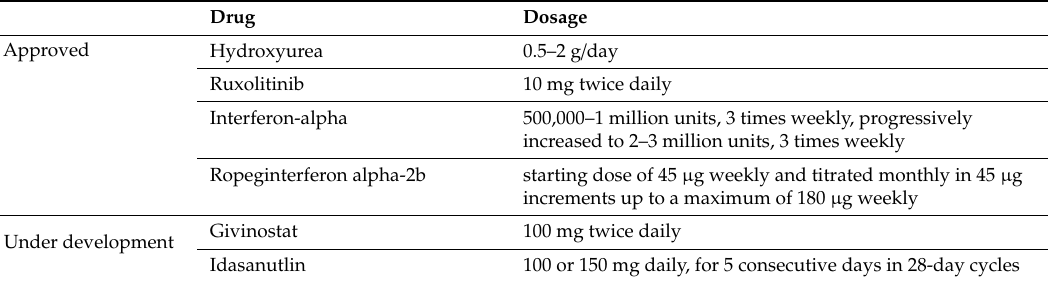
Table 3. Therapeutic landscape for polycythemia